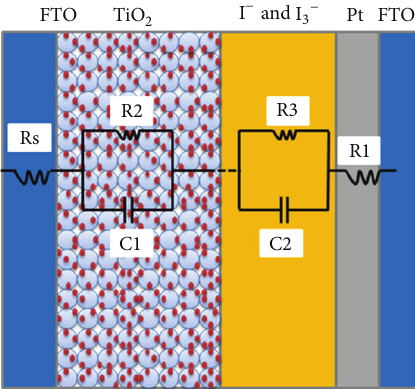
Figure 7: The schematic diagram of the internal resistance related to the charge transfer kinetics in the DSSCs.